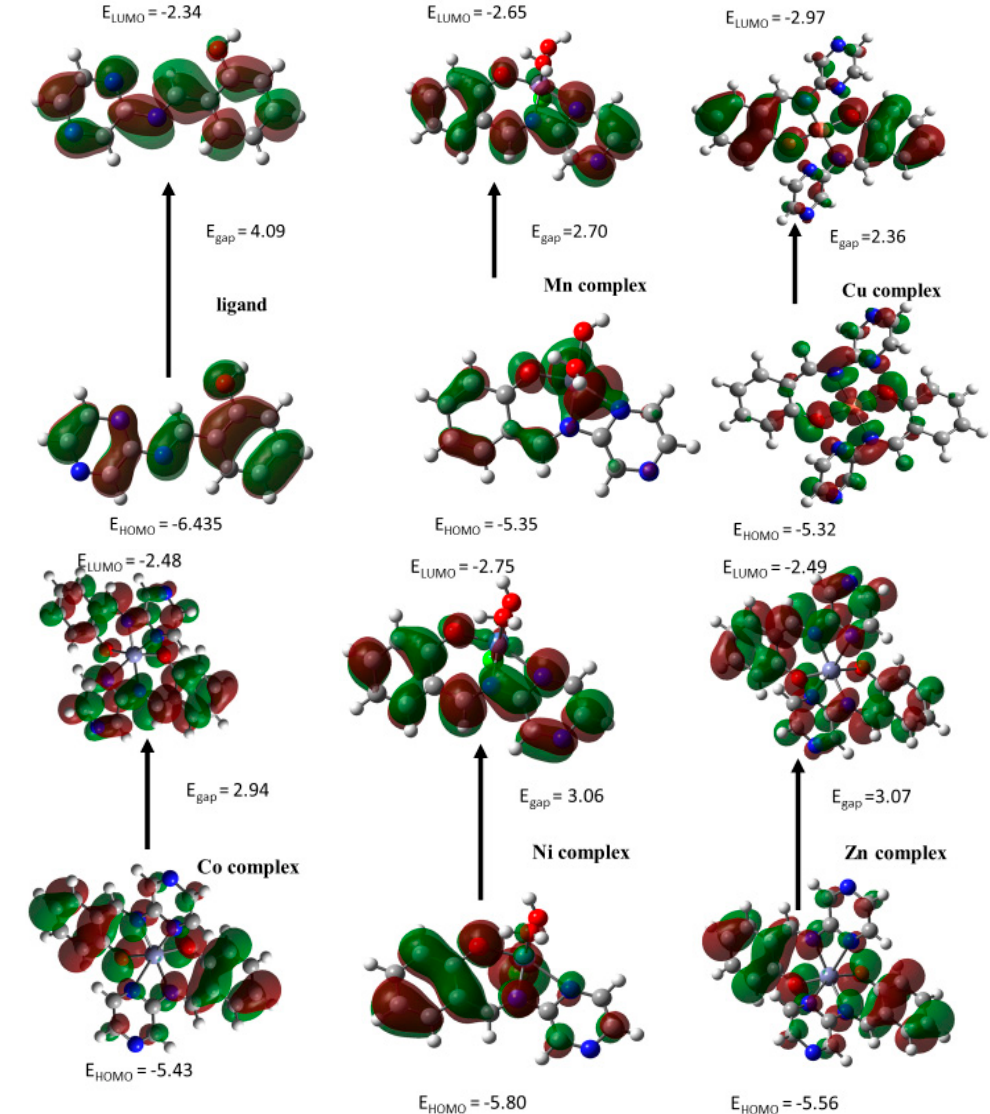
Figure 8. The 3D HOMO and LUMO plots of the ligand and the bivalence metal complexes. Table 2. The calculated quantum chemical parameters of the ligands and their metal complexes .